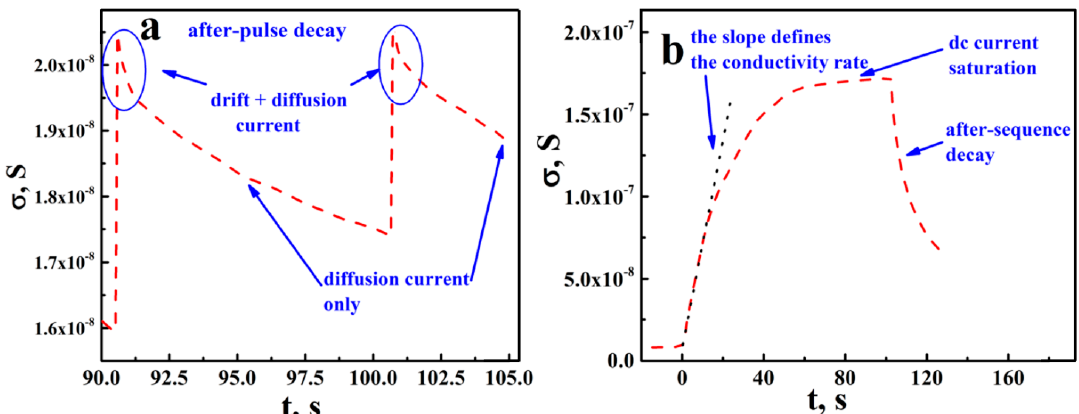
Figure 4. Examples of the decay kinetics in the photo-induced dc conductance of aTNTA; ( a ) a short-term (after-pulse) decay; ( b ) a long-term (after-sequence) decay; the red dashed lines correspond to the smoothed time-dependent data on the dc conductance; ( a ) the repetition rate is 0.1 Hz; the irradiation energy fluence is about 3.5 mJ/cm 2 ; the initial stage of photo-activation; ( b ) the repetition rate is 2 Hz; irradiation energy fluence is about 3.5 mJ/cm 2 ; duration of the pulse sequence is 103 s.